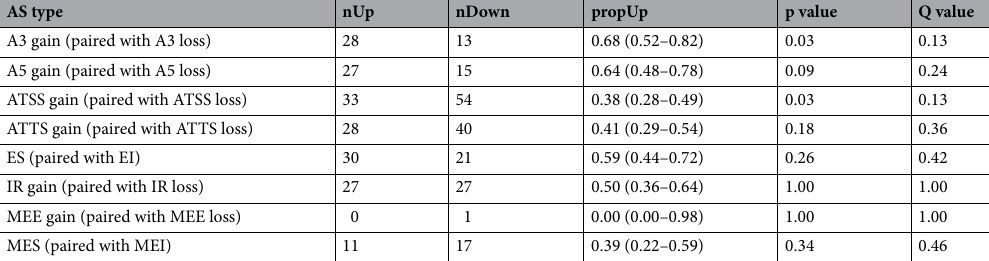
Table 2. The number of specific splice events and associated opposing events. The number of genes with a specific AS type is obtained by comparing non-survivors versus survivors. For examlpe, there were 28 genes filtered by significance test with A3 gain and 13 genes with significant A3 loss. nUp number of up regulation, nDown number of downregulation, propUp proportion of upregulation, AS alternative splicing, IR intron retention, A5 alternative 5 ′ donor site (changes in the 5 ′ end of the upstream exon) , A3 Alternative 3 ′ acceptor site (changes in the 3 ′ end of the downstream exon), ATSS alternative transcription start site, ATTS alternative transcription termination site, ES exon skipping, MES multiple exon skipping, skipping of > 1 consecutive exons, MEE mutually exclusive exons.